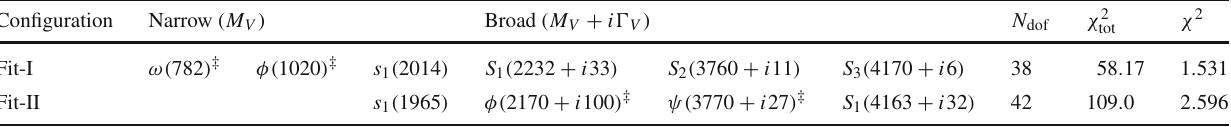
Table 1 Comparison between the Fit-I and Fit-II. Fit-II is our preferred fit. The ‡ represents an input quantity that was fixed to the physical state from PDG [49] (mass and width are constant in the fit)